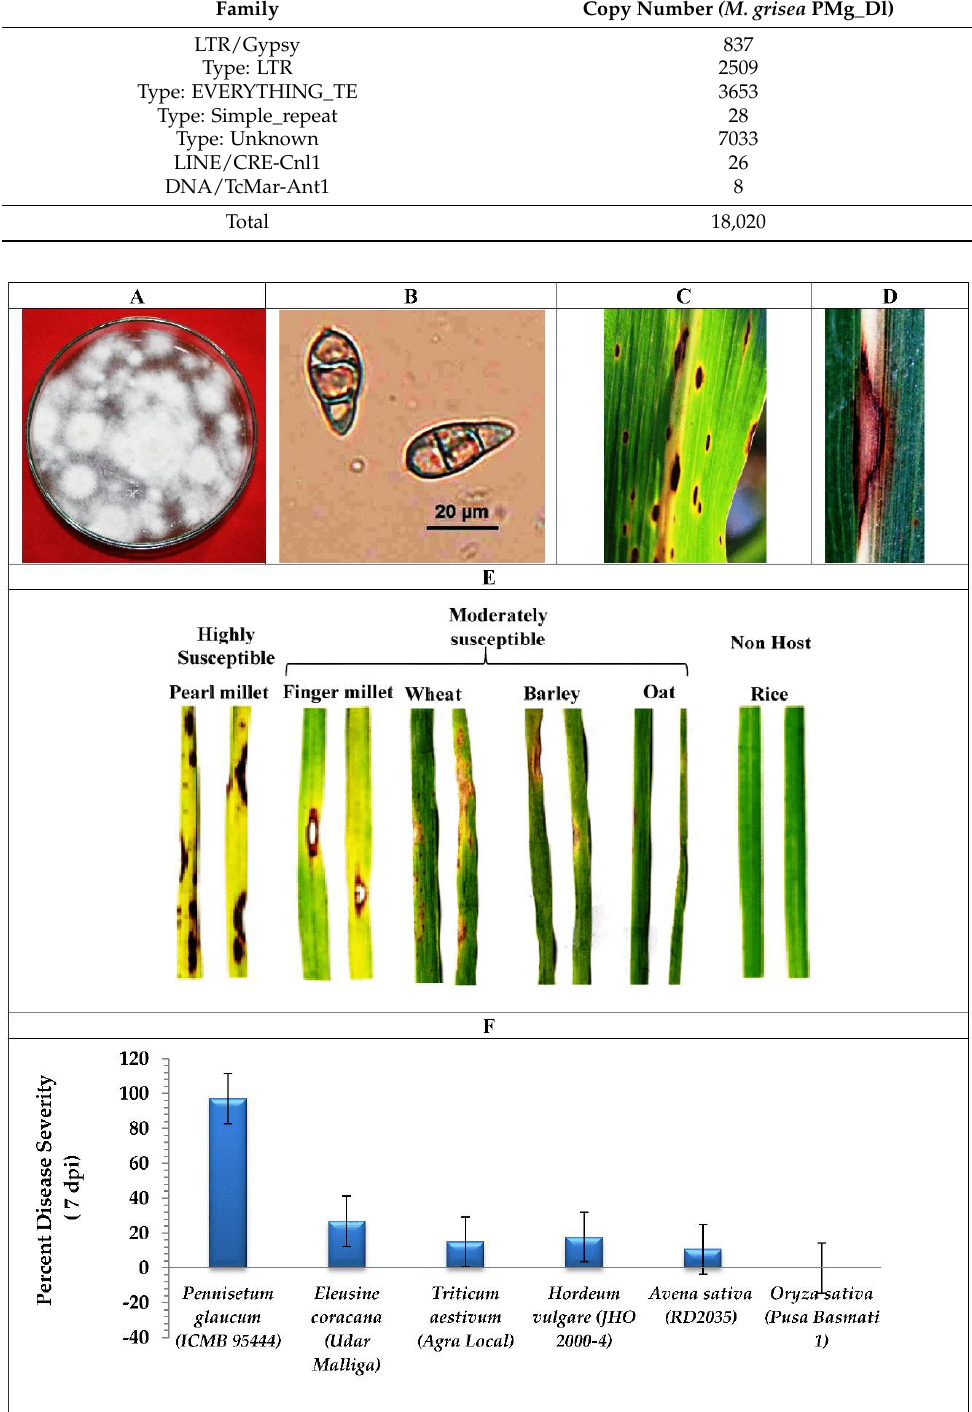
Figure 3. Mycelial and conidial features, pathogenicity, and host range of Magnaporthe grisea PMg_Dl. ( A ) Complete mycelial growth of M. grisea PMg_Dl showing sporulation as gray coloration. ( B ) Microscopic image showing three-celled conidia at 400 X magnification. ( C ) Blast lesions on pearl millet leaf in the field. ( D ) Close-up images of necrotic lesion on pearl millet leaf. ( E ) Pathogenicity assay showing high susceptibility of pearl millet to M. grisea PMg_Dl; finger millets, wheat, barley, and oat showed moderate susceptibility; rice is not a host to M. grisea PMg_Dl. ( F ) Blast severity score recorded on various Poaceae members; bar represents standard error of the mean difference.